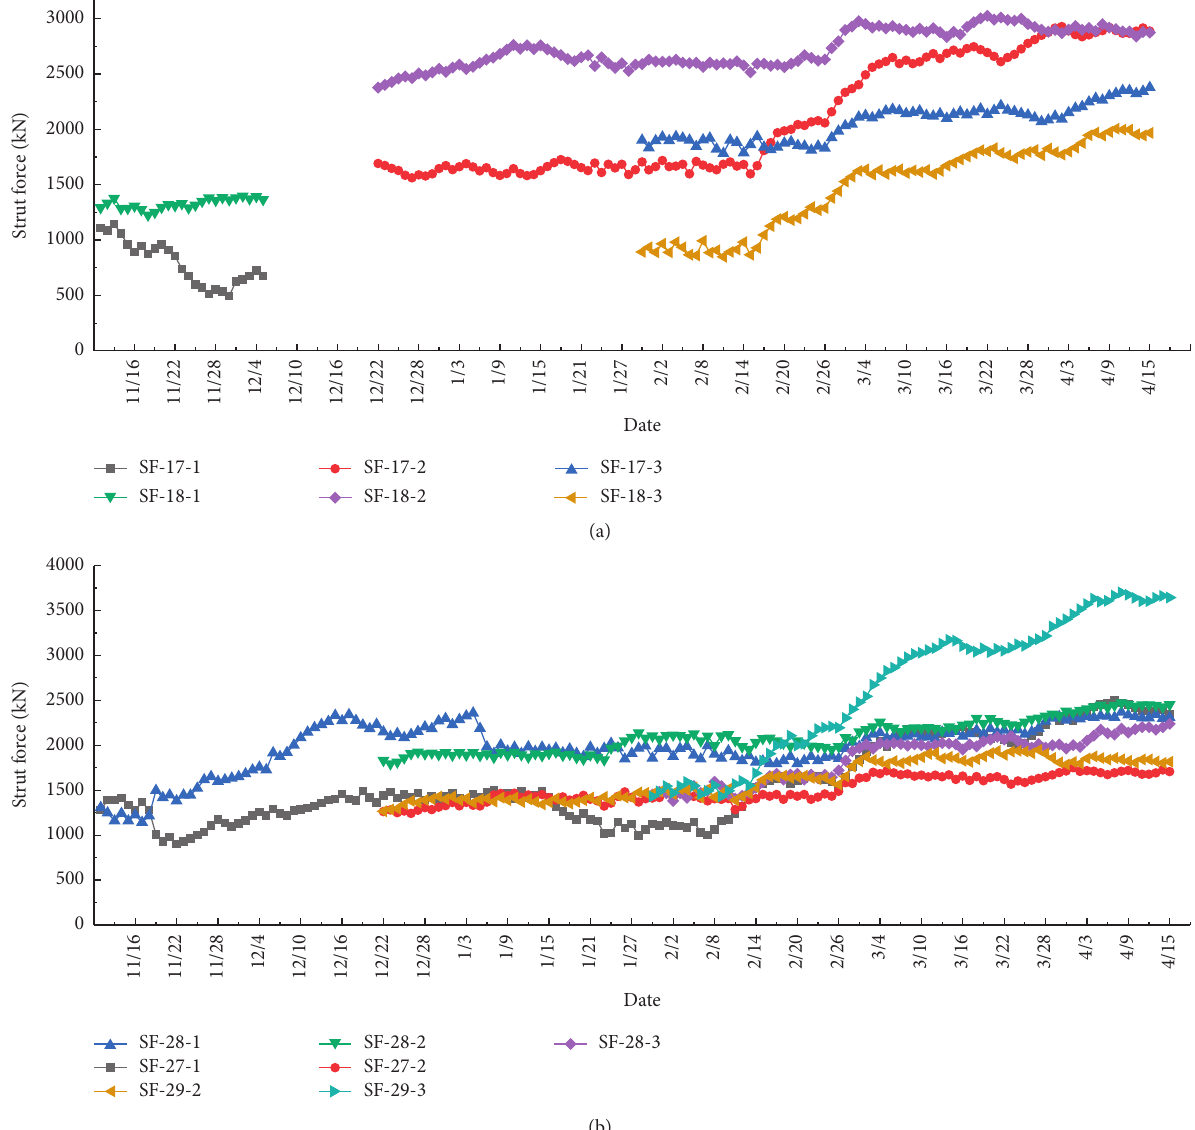
Figure 9: Monitoring results of the strut force at the west side (a) SF17 and SF18 and the south side (b) SF27, SF28, and SF29 during PIP